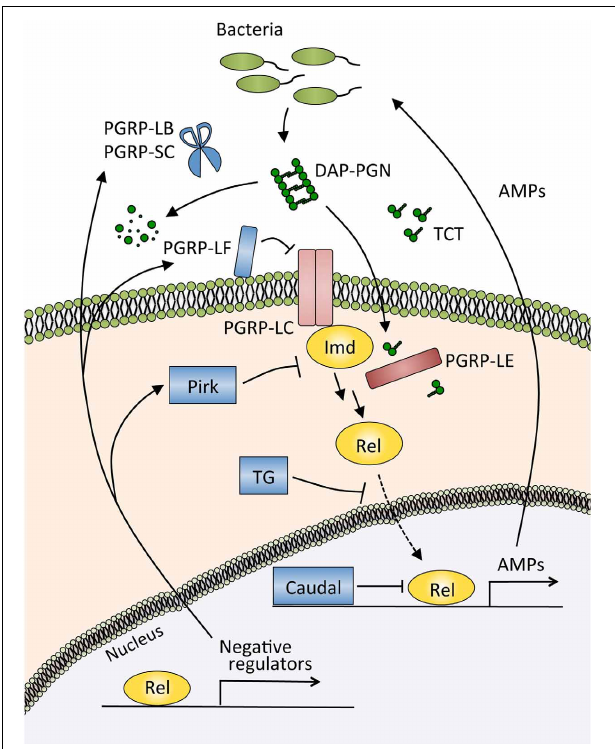
FIGURE 3 | The Imd pathway and its negative regulators in the gut. The Imd pathway is activated by the recognition of diaminopimelic acid-type peptidoglycan (DAP-PGN) by the membrane receptor PGRP-LC, or tracheal cytotoxin (TCT) by the intracellular receptor PGRP-LE. Activated PGRP-LC or PGRP-LE then recruits the adaptor protein Imd, which triggers the signaling cascade of the pathway and induces the nuclear translocation of Relish, a nuclear factor- κ B (NF- κ B) transcription factor of Drosophila . The NF- κ B protein Relish activates the expression of antimicrobial peptides (AMPs) and negative regulators of this pathway. PGRP-LB and PGRP-SC catalyze the degradation of peptidoglycan and TCT, resulting in a decrease in the amount of ligands for the recognition receptors PGRP-LC and PGRP-LE. PGRP-LF and Pirk inhibit the activity of those receptors, transglutaminase (TG) blocks the nuclear translocation of Relish, and Caudal modulates the transcriptional response of Relish.